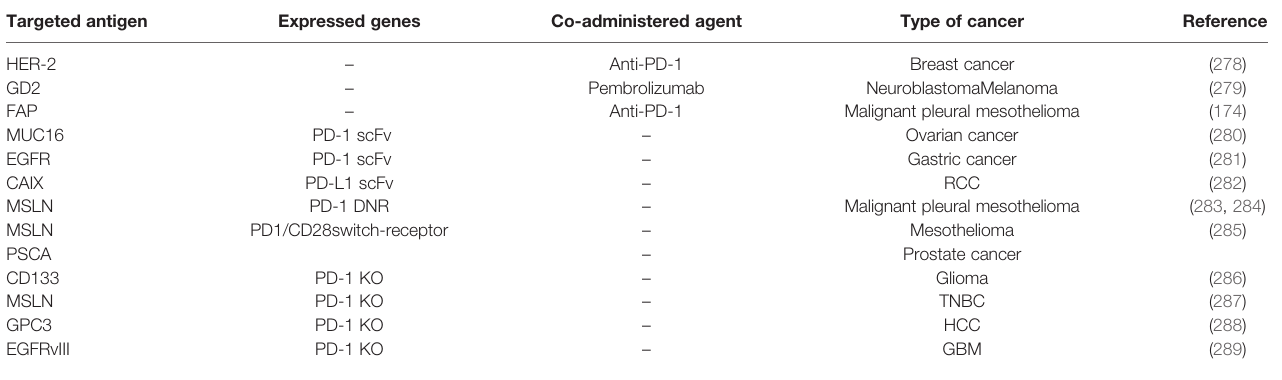
TABLE 9 | Summary of preclinical studies on CAR-T cells to overcome the inhibitory effect of ICs. Targeted